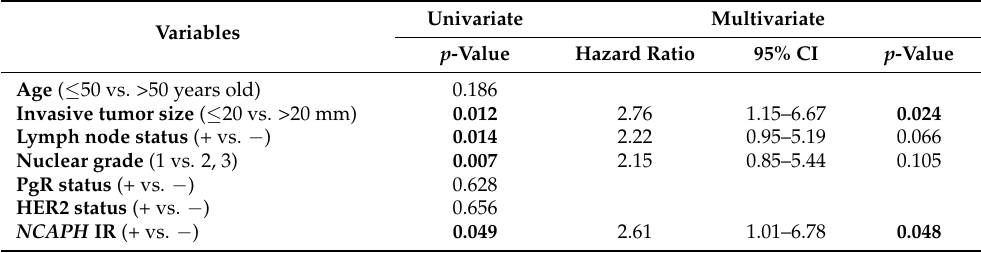
Table 4. Univariate and multivariate analyses of disease-free survival with clinicopathological parameters including NCAPH immunoreactivity in ER-positive breast cancer patients.